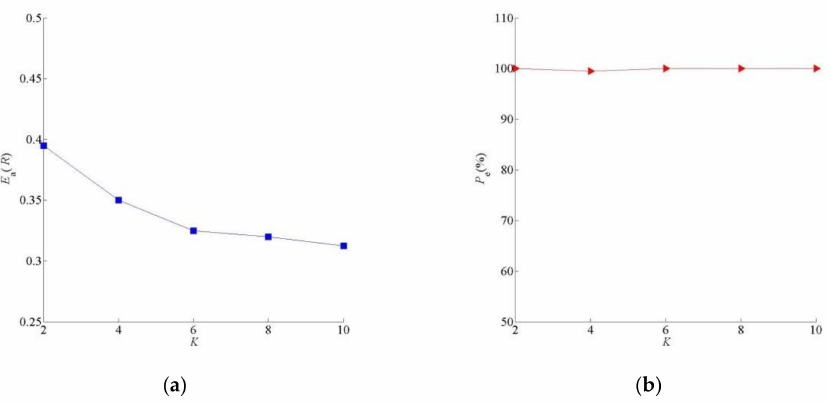
Figure 8. Effect of number of groups K on VTL. ( S = 100 × 100 m 2 , N t = 100, r a = 40%, R a = R = 20 m, E GPS = 0.1 m). ( a ) Averag estimation error E a . ( b ) Estimation percentage P e .